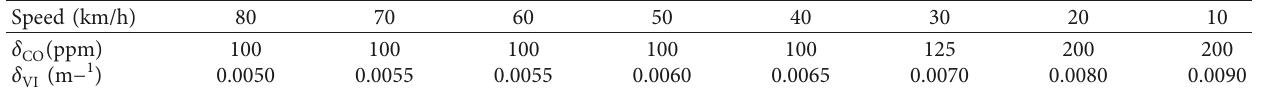
and δ related with driving speed. CO VI